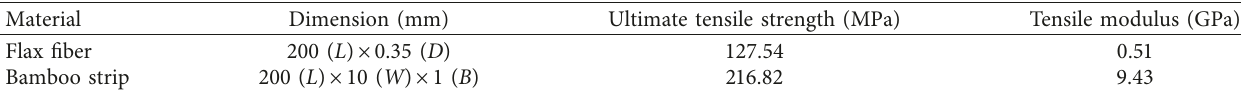
Figure 2: Tensile force vs. deformation of (a) flax fiber and (b) bamboo strip. Table 2: Parameters of flax fiber and bamboo